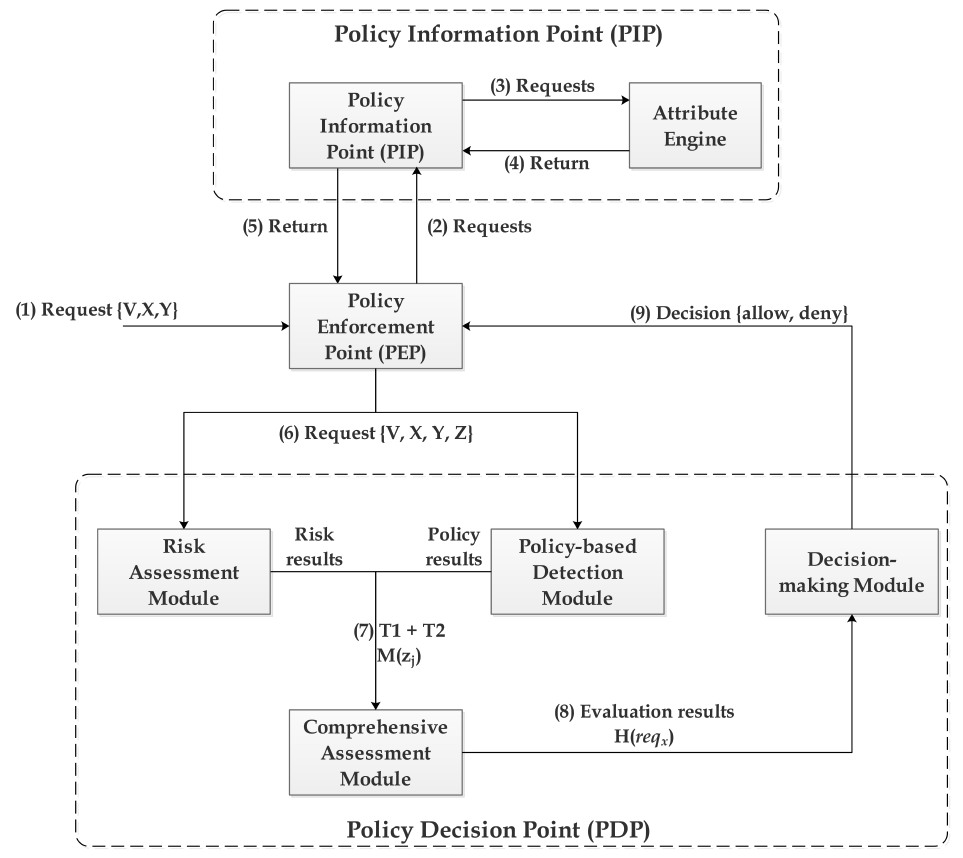
Figure 3. Risk access control model based on